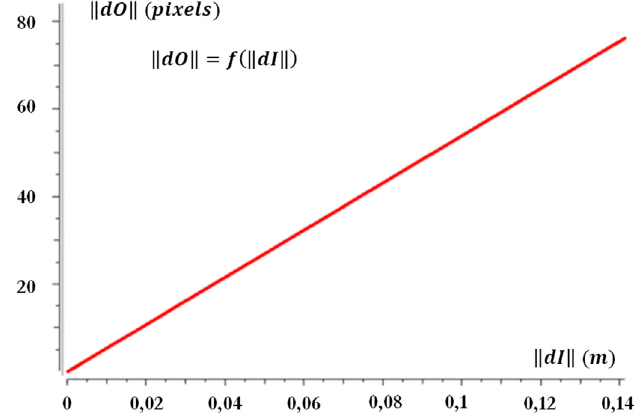
Fig. 21. Monte-Carlo estimation of pinhole model uncertainties generation.